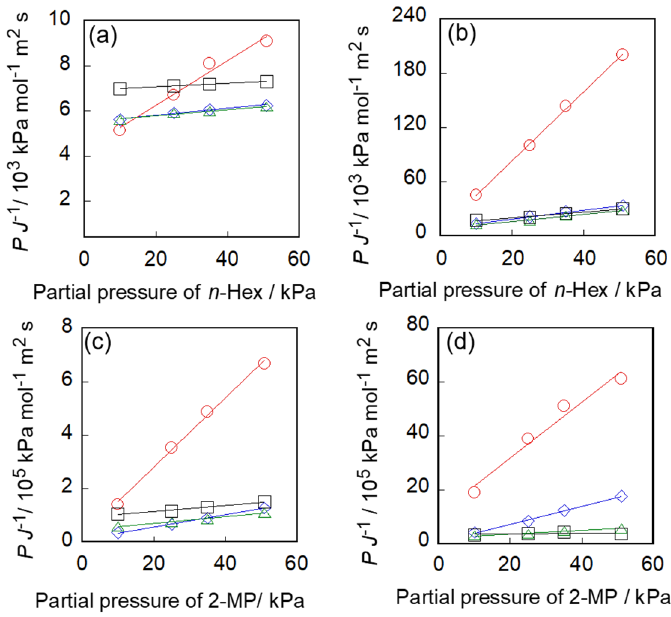
Figure 4. The plots of PJ − 1 against P . ( a , b ) n -hexane through S-1 S and S-1 M . ( c , d ) 2-methylpentane through S-1 S and S-1 M . ○, 373; □, 473; ▵ , 573 and ◊, 653 K.